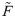
Factorization-based versus alignment-based methods.(A) Factorization-based single-view learning methods. They typically factorize a data matrix X from single view (e.g., gene expression matrix of samples by genes) into a product of matrix G (coefficient matrix) and matrix F˜ (dictionary matrix or pattern matrix). Because matrix factorization has an intrinsic clustering property [8], the matrix F˜ can represent a clustering structure of the view (i.e., the soft clustering assignments or indicators). For example, F˜ reveals 3 different gene clusters, a, b, and c, as denoted in the figure. (B) Factorization-based multiview learning methods. They factorize different matrices from multiomics, e.g., gene expression X(1) (i.e., green matrix), protein expression X(2) (i.e., blue matrix), and chromatin accessibility X(3) (i.e., orange matrix), into a product of different coefficient matrices G(k)(k = 1,2,3) and the common dictionary matrix F˜. This common representation enables revealing of cross-talk patterns among genes, proteins (more precisely, TFs), and regulatory elements (i.e., enhancers); e.g., a TF binds to a region to regulate a gene's expression. (C) Alignment-based multiview learning methods. The 3 input omic matrices are projected via functions f(k)(k = 1,2,3) onto spaces where their internal relationships are revealed. These representations of different omics are pairwise coordinated to each other via the term Ωco. For example, the figure demonstrates the pairwise alignments between X(1), X(2) and between X(2), X(3) to reveal cross-talk patterns between TFs and enhancers, and between enhancers and gene expressions. (Alignment between X(1) and X(3) is not shown for making the figure concise.) TF, transcription factor.